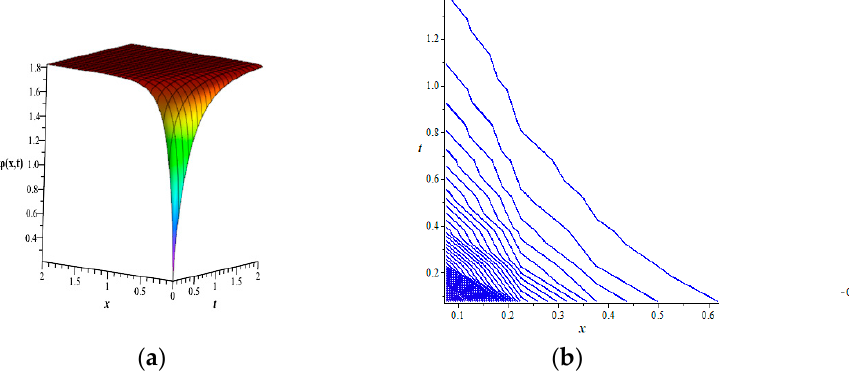
ϕ of Equation (55) for the para- = t and 1,8.0,5.0 for 2D